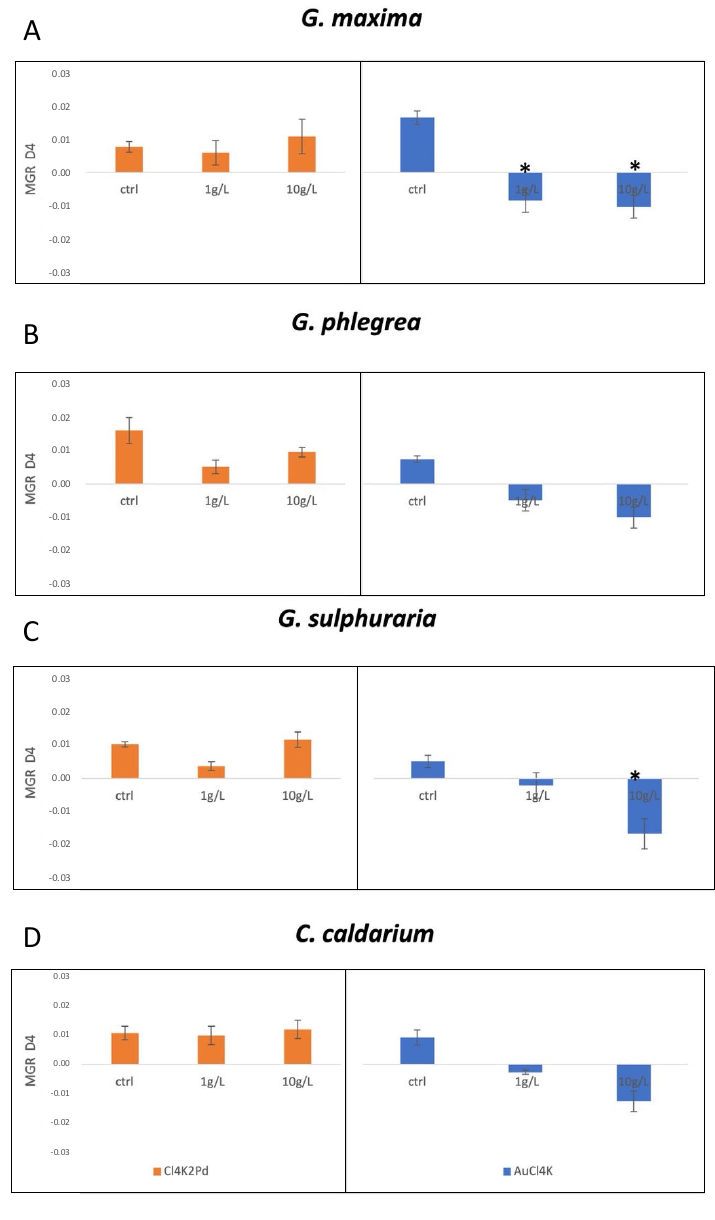
Figure 1. Evaluation of metal tolerance through MGR monitoring after 4 days (96 h). Maximum growth rate in the presence of different concentrations of palladium (Cl 4 K 2 Pd, orange, left panel) and gold (AuCl 4 K, blue, right panel), for the species: ( A ) G. maxima; ( B ) G. phlegrea; ( C ) G. sulphuraria; ( D ) C. caldarium . Error bars represent standard deviation of three replicates. (*) = p ‐ value ≤ 0.000000001 calculated by T ‐ test.